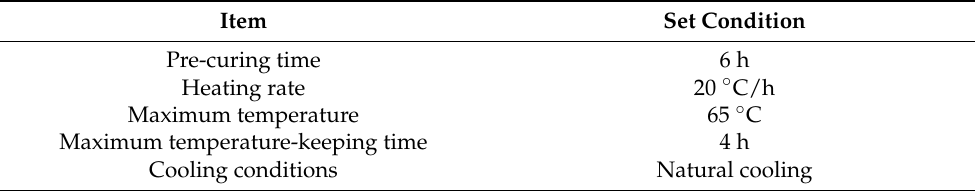
Table 6. Steam curing conditions.